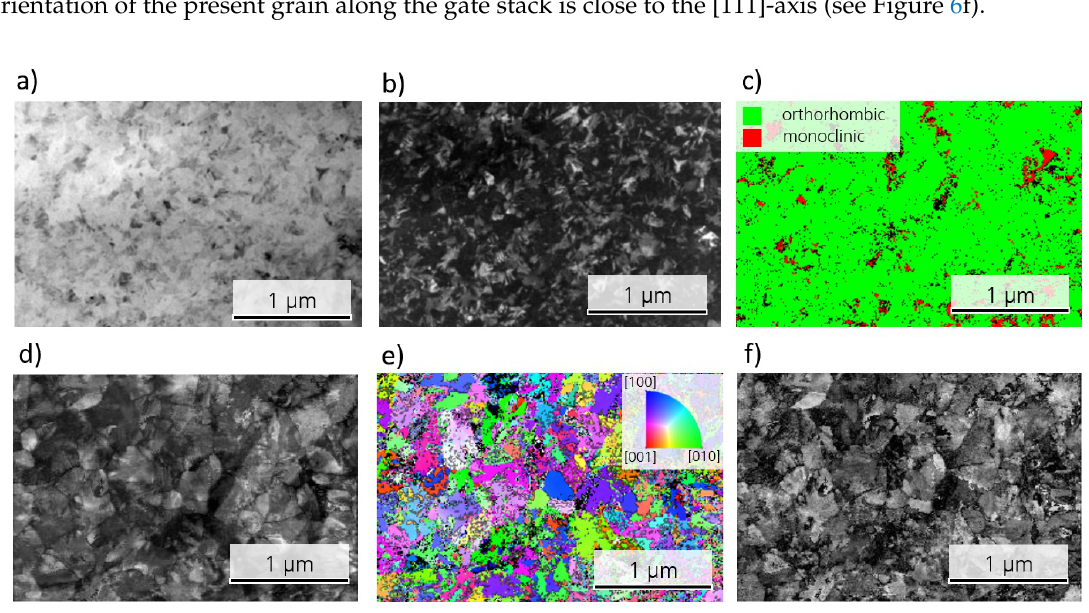
Figure 5. STEM analysis of a planar MFIS HSO layer. ( a , b ) shows the bright field and conical dark field, respectively. The extracted phases are visualized in ( c ) and the reliability of their fit is shown in ( d ). Analogously, ( e , f ) shows the crystallographic orientation and the reliability of the fit,